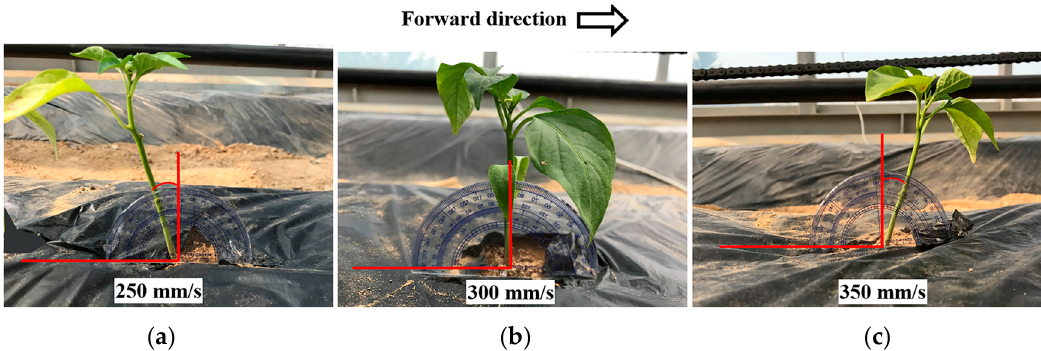
Figure 9. Uprightness of pepper seedlings after transplantation at different forward speed levels of transplanting operations of 250 ( a ), 300 ( b ), and 350 mm/s ( c ).